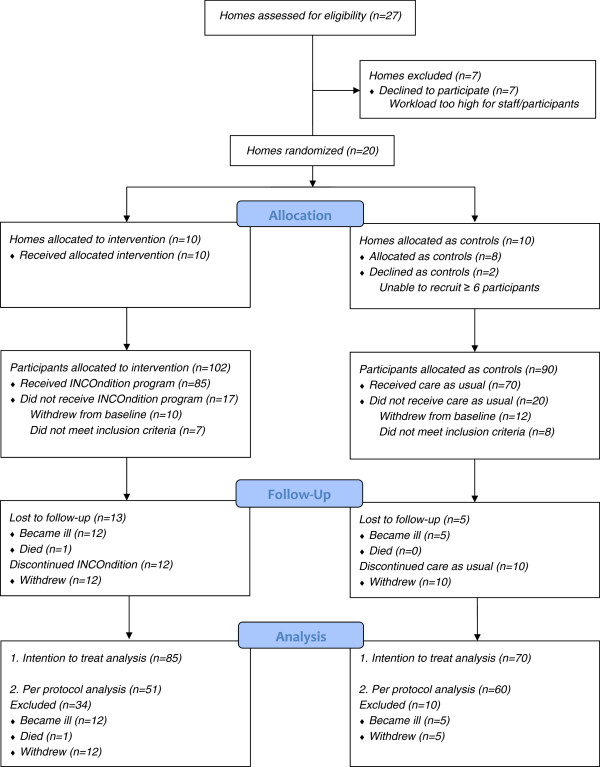
Study flowchart.